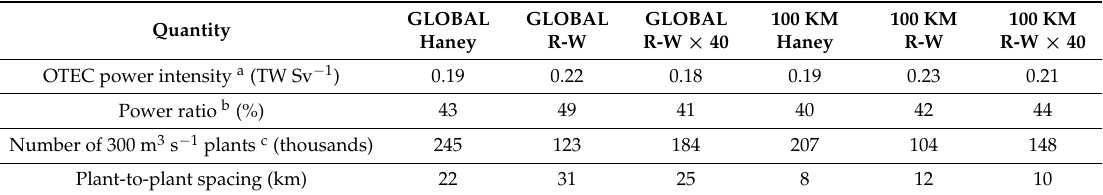
Table 1. Some characteristics of OTEC overall peak power